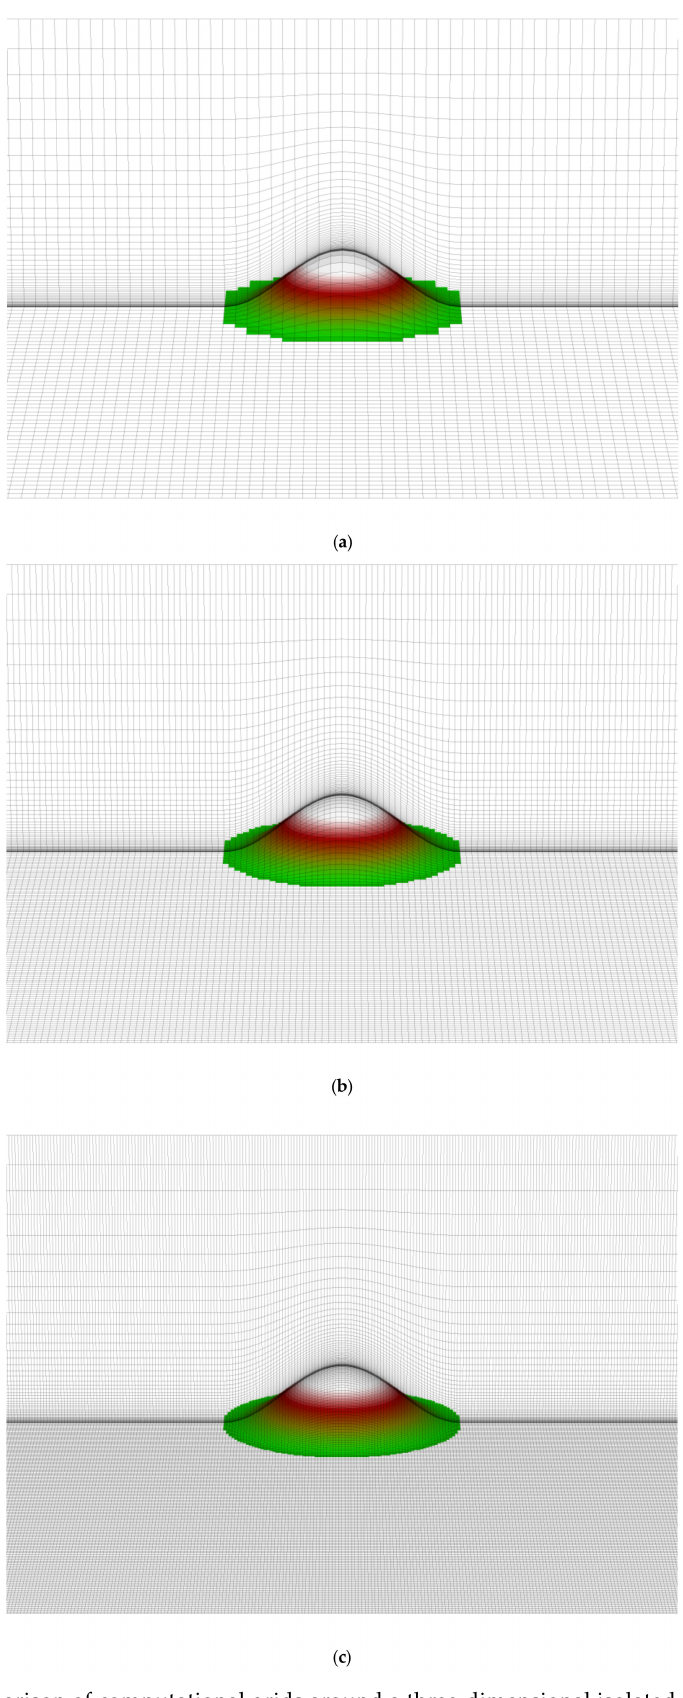
Figure 3. Comparison of computational grids around a three-dimensional isolated steep hill. Here, h represents the height of the isolated hill. ( a ) Coarse grid: 151 × 101 × 51 ( ∆ x = ∆ y = 0.2 h, ∆ z = 0.003–0.5 h); ( b ) Medium grid: 301 × 201 × 51 ( ∆ x = ∆ y = 0.1 h, ∆ z = 0.003–0.5 h); ( c ) Fine grid: 601 × 401 × 51 ( ∆ x = ∆ y = 0.05 h, ∆ z = 0.003–0.5